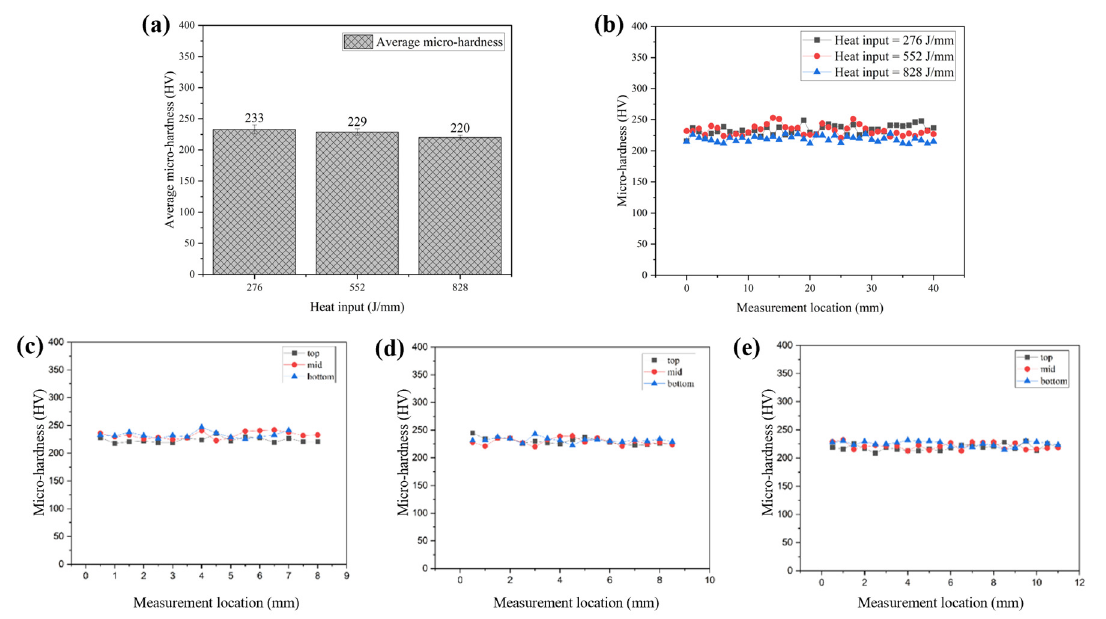
Figure 11. Micro-hardness of the samples with different heat inputs. ( a ) Average micro-hardness of each heat input. ( b ) Comparison of vertical micro-hardness and ( c – e ) comparison of horizontal mi- cro-hardness of different heat input: ( c ) 276 J/mm, ( d ) 552 J/mm and ( e ) 828 J/mm.